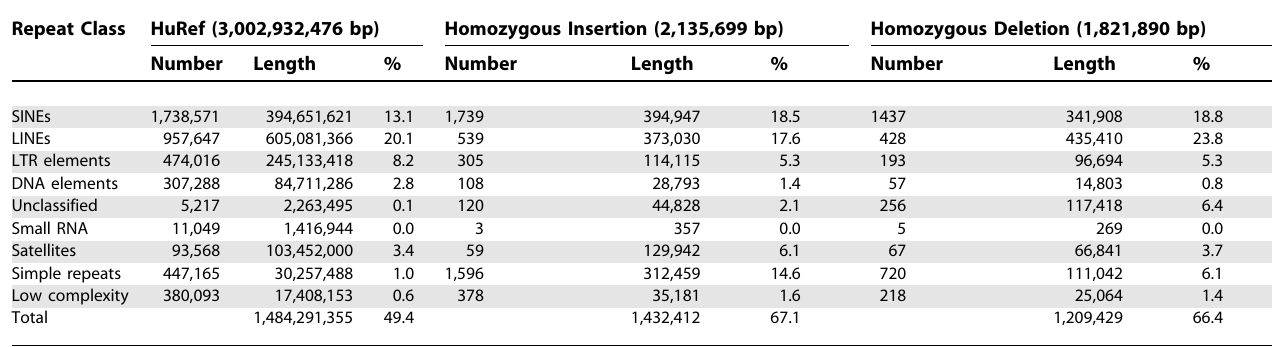
Table 7. Repetitive Elements in the Complete HuRef Assembly, Homozygous Insertions and Deletions Were Identified Using RepeatMasker